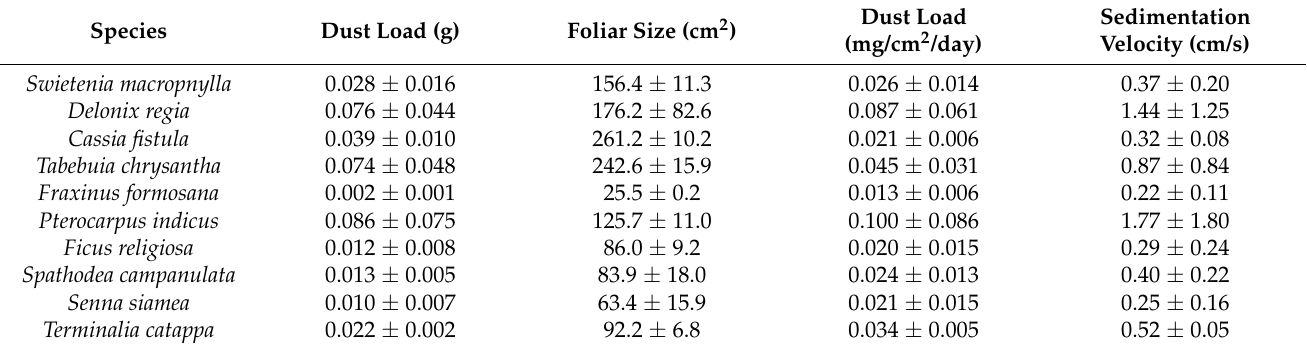
Table 8. Average dust load and foliar sizes in sample CAZs the south part of